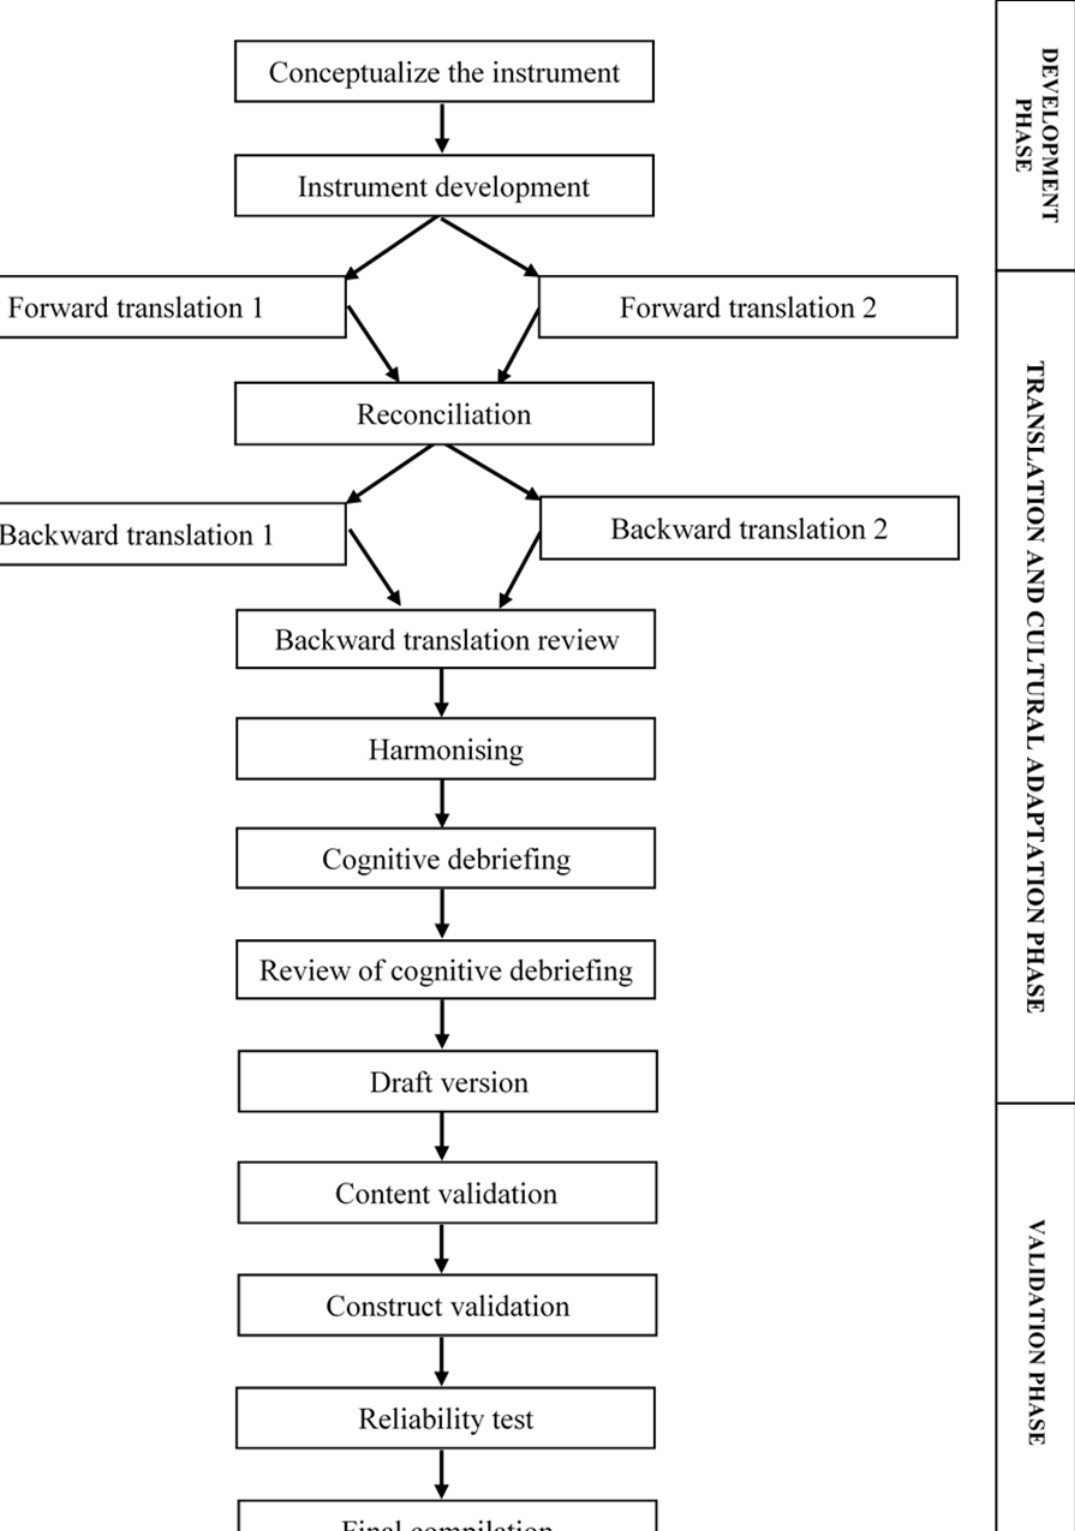
Figure 1. The cross-cultural adaptation and evaluation process.